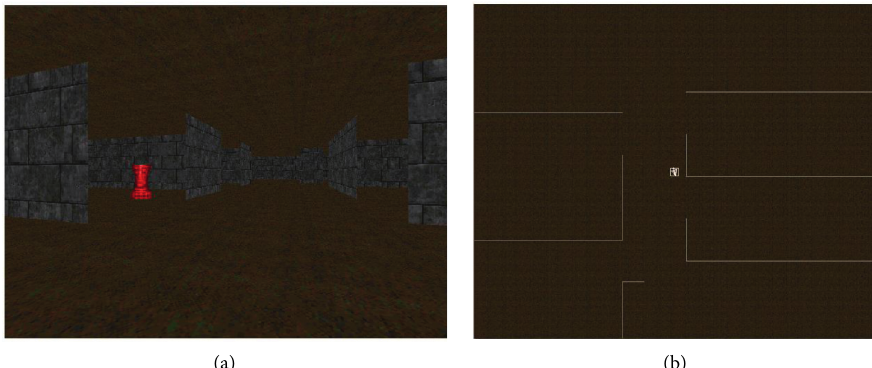
Figure 5: Illustration of a virtual indoor navigation environment. (a) First-person view of the agent in the environment. (b) 2D floor plan of the